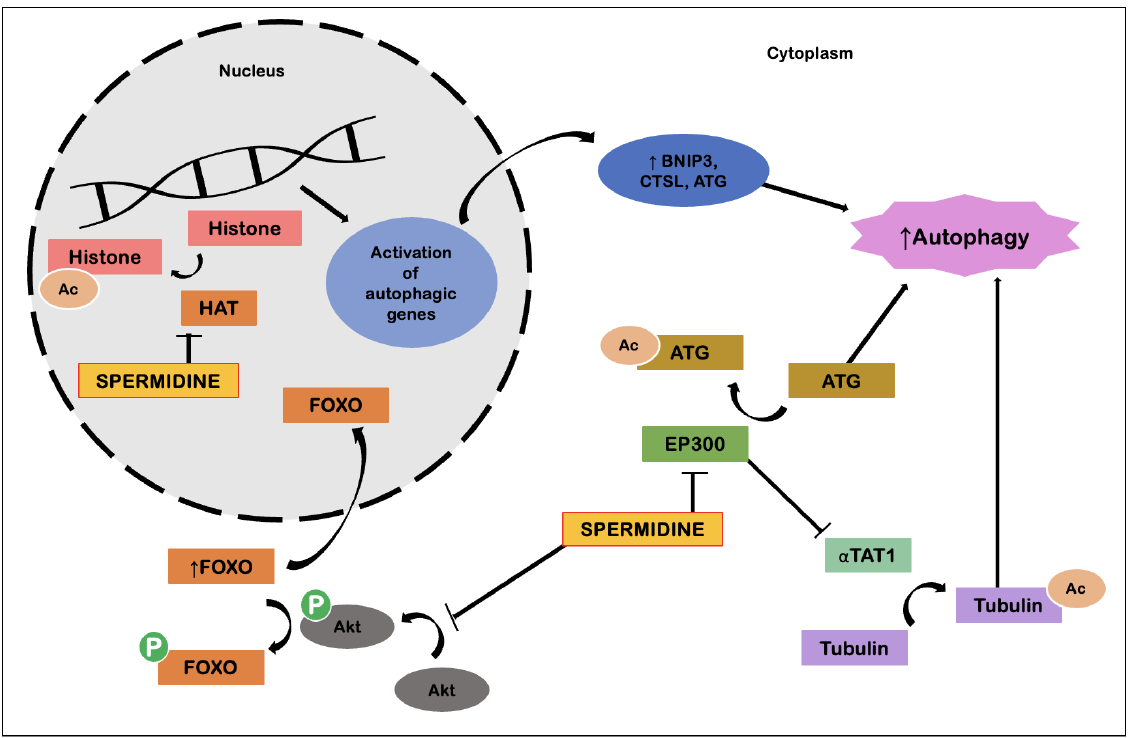
Figure 6. Spermidine-induced induction of autophagy (adapted from Madeo et al. [48]). Abbre- viations: Ac, acetylation; Akt, protein kinase B; ATG, autophagy-related proteins; BNIP3, Bcl-2 interacting protein 3; CTSL, cathepsin L; EP300, E1A binding protein P300; FOXO, forkhead box O; HAT, histone acetyltransferase; P, phosphorus; αTAT1, alpha tubulin acetyltransferase 1.